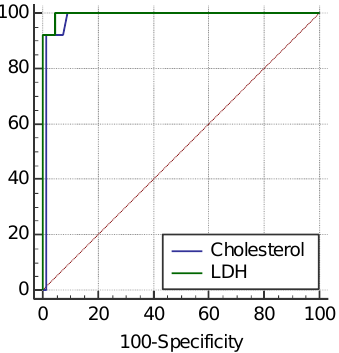
Figure 2. ROC Curve analysis in transudative